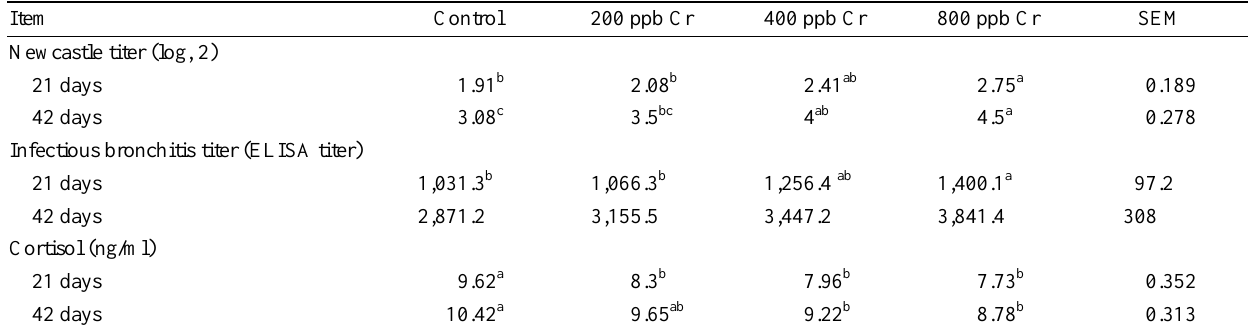
Table 2. Effect of chromium supplementation on antibody titer against Newcastle and infectious bronchitis virus and cortisol levels at different ages of broiler Item